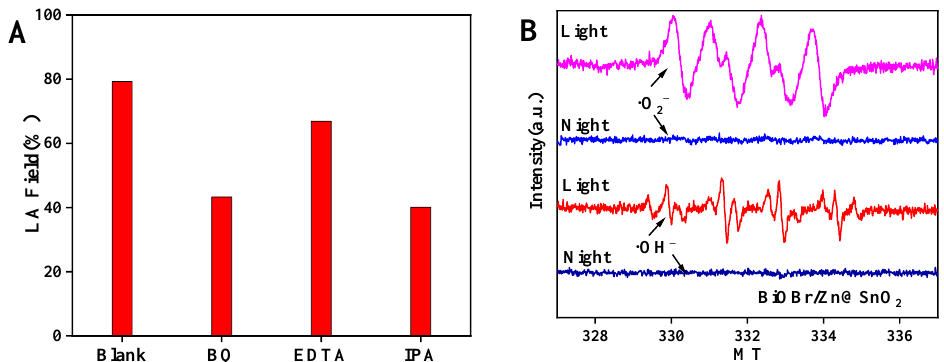
Figure 8. Effect of adding various inhibitors to inhibit ·O 2 − , H + and ·OH − radicals on lactate yield ( A ), − and · OH − radicals ( B ). DMPO ESR spin-labelled ·O 2 − and ·OH − radicals ( B ). ( A ), DMPO ESR spin-labelled · O 2